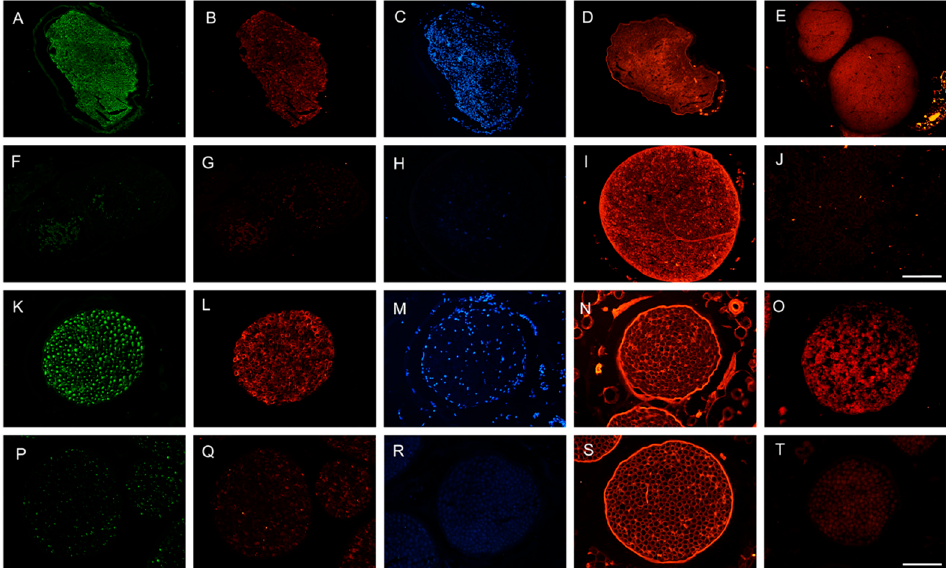
Figure 2. Representative micrographs showing immunofluorescence of myelinated axons ( A , F , K , G ), Schwann cells ( B , G , L , Q ), nuclei ( C , H , M , R ), extracellular matrix proteins ( D , I , N , S ) and myelin ( E , J , O , T ), in a control rat sciatic nerve ( A , B , C , D , E ), in a decellularized rat nerve ( F , G , H , I , J ), in a control sheep peroneal nerve ( K , L , M , N , O ) and in a decellularized sheep nerve ( P , Q , R , S , T ). Scale bar 150